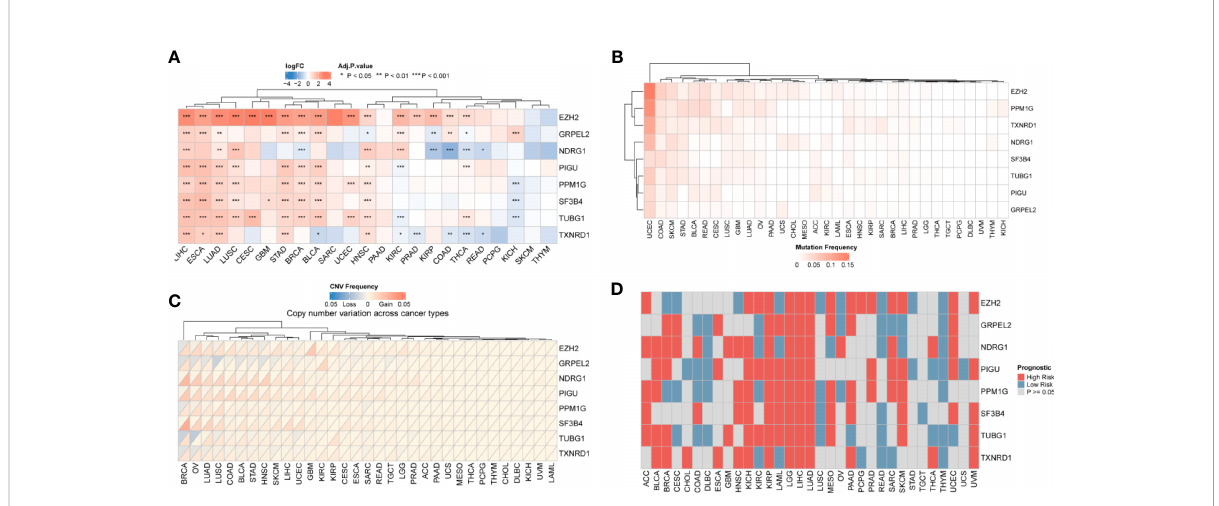
FIGURE 3 Pan-cancer results of hub genes. (A) Differential Expression of genes: eight genes were differentially expressed in most cancer types. The darker the color, the greater the fold change (B) Mutation frequency: the hub gene mutation was relative stable in all types of cancer except UCEC. (C) Copy number variation of hub genes. HCC had minor changes in the copy number of the 8 hub genes (D) Prognosis of hub genes. The red square represents a risk factor in the cancer, and the blue square represents a protective factor. Gray indicates that the prognosis of the tumor does not affect the